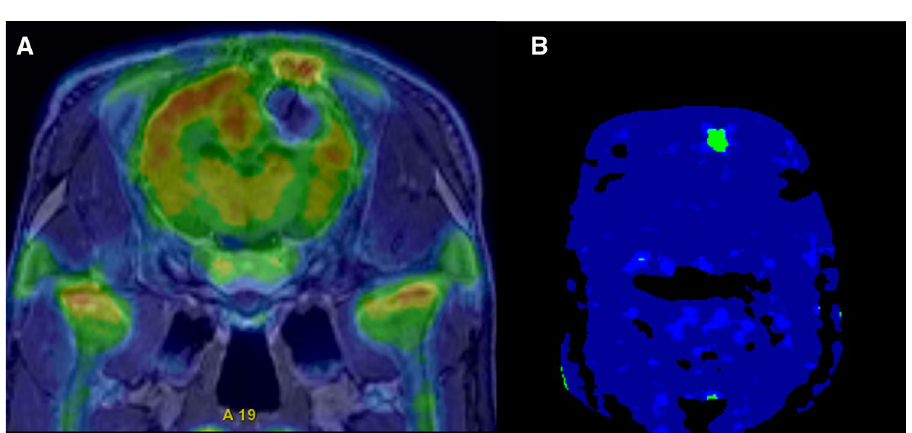
Figure 5. Postoperative static FDG-PET scan acquired 30–45 min after injection. ( A ) Relatively well-defined near-spherical metabolic defect symmetrically surrounding the position of the freezing probe showing profoundly and almost homogenously reduced FDG activity (light blue arrow) compared to the same area in the contralateral hemisphere (dotted white oval). ( B) PET compartment of dynamic FDG scan showing enhanced k 3 signal, indicating increased activity (yellow